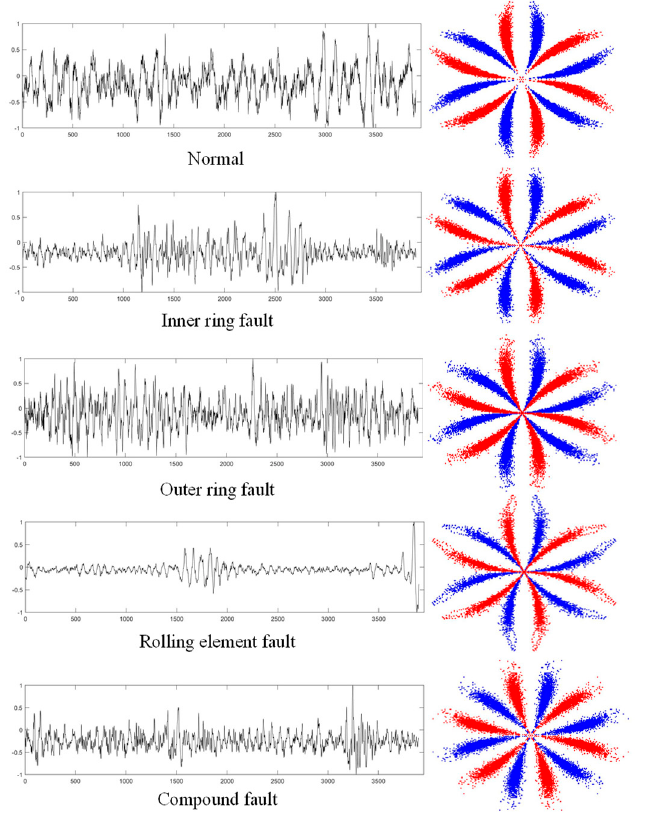
Figure 15. Bearing vibration signals and SDP images with different faults.